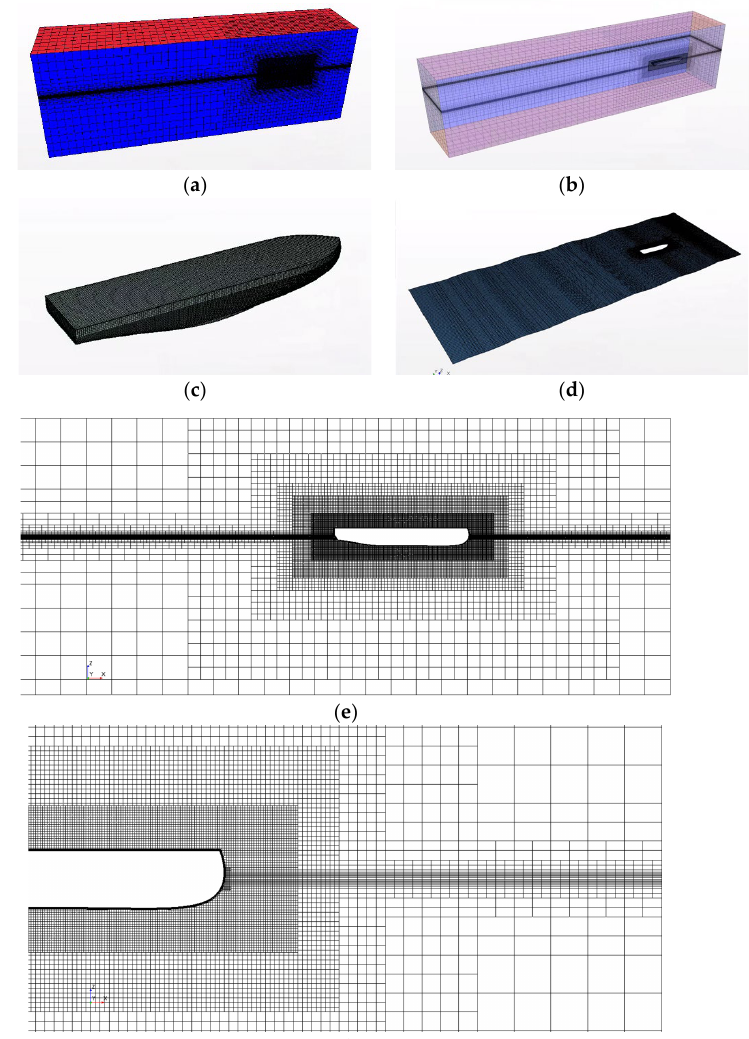
Figure 2. Illustrations of computational mesh; ( a ) Volumatic mesh (b ) Surface mesh on boundaries ( c ) Surface mesh on the hull ( d ) Reconstructed free surface mesh ( e ) The overall mesh of computational domain ( f ) Local mesh in computational domain.